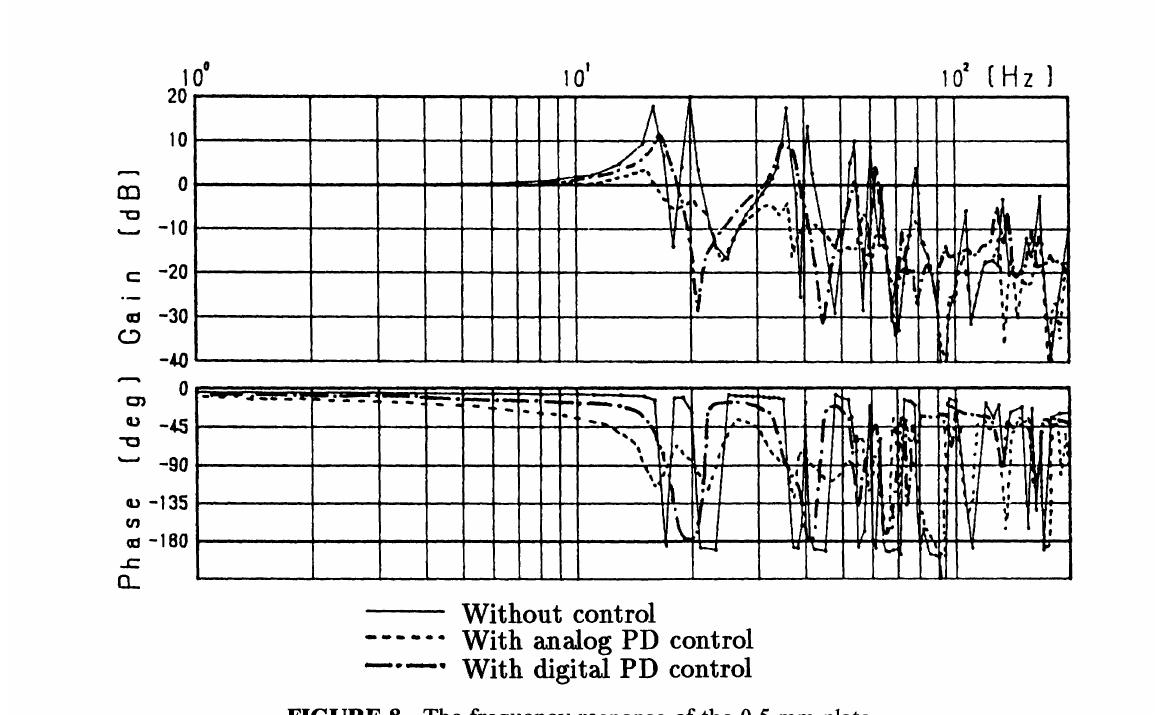
FIGURE 8 The frequency response of the 0.5 mm